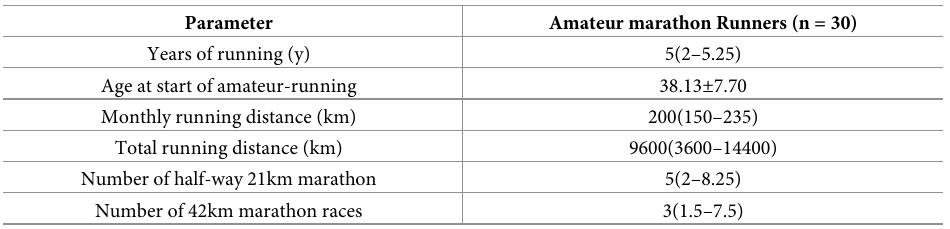
Table 1. Description of amateur marathon